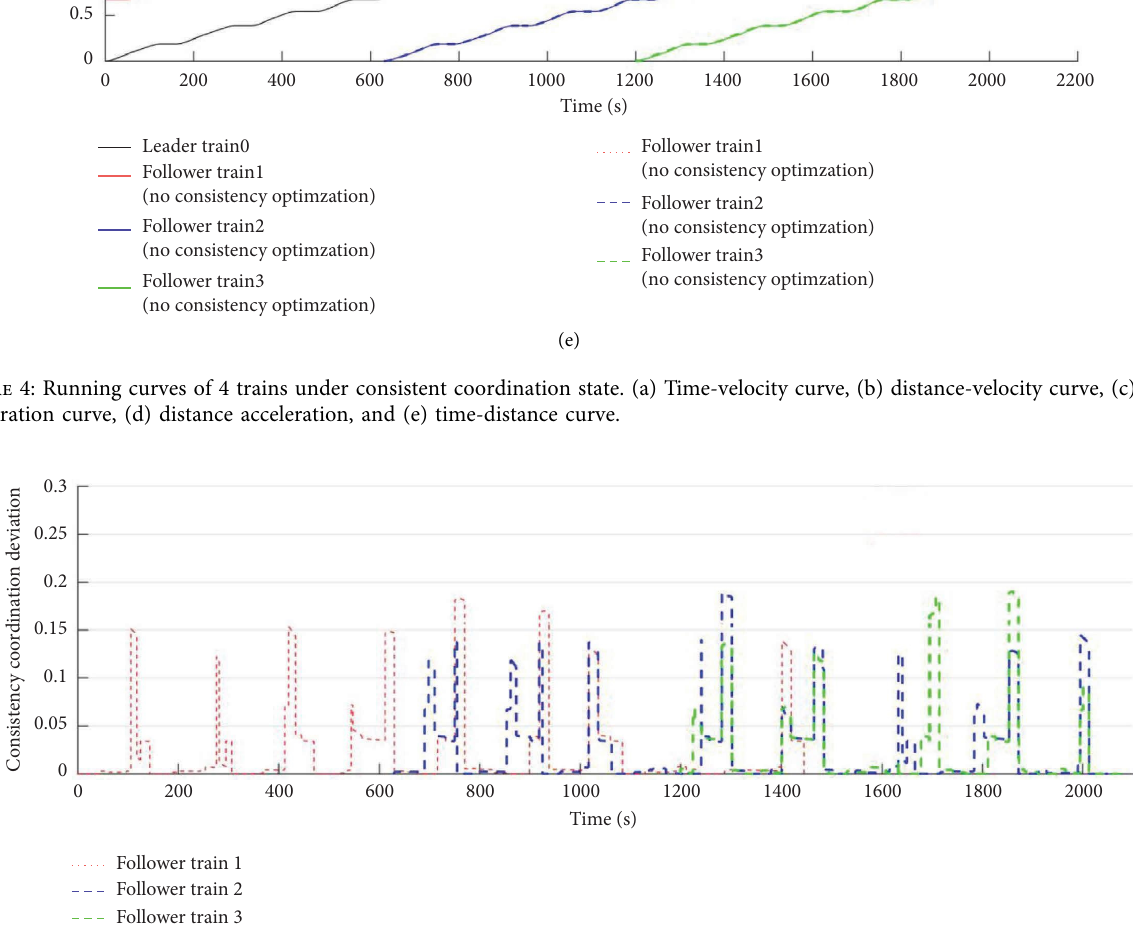
Figure 5: Variation trend of consistency coordination deviation β